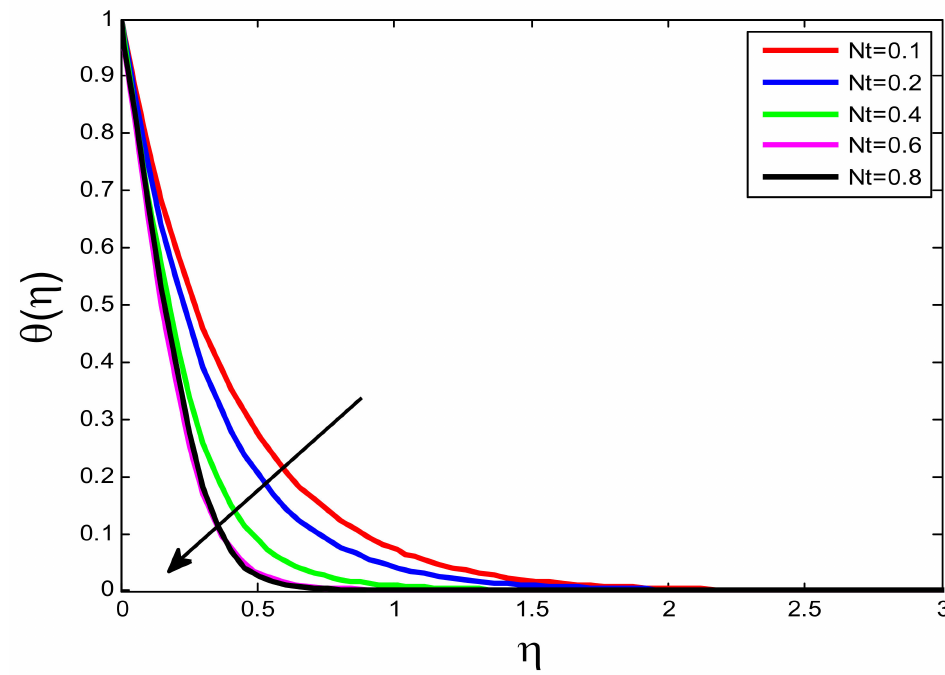
Figure 16. Influence of Nt on θ ( η ) .